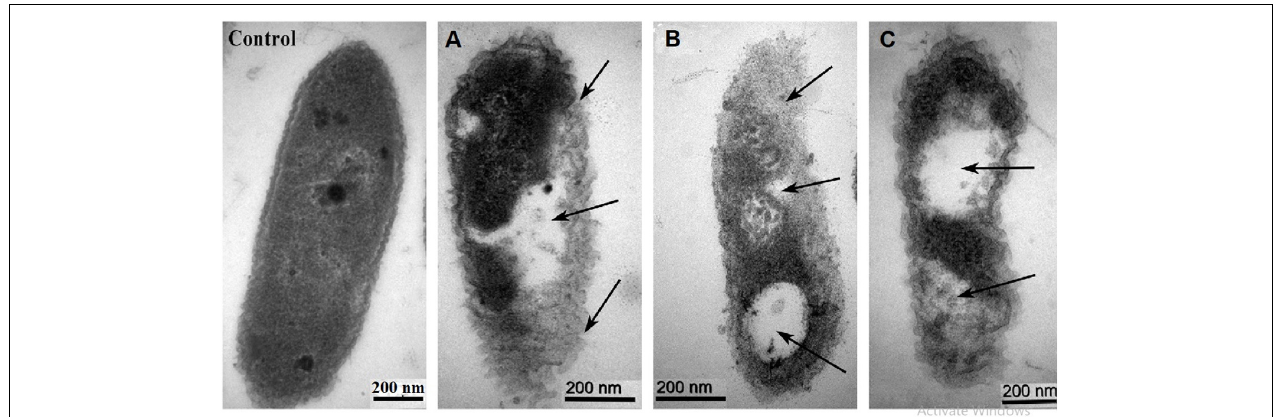
FIGURE 6 | TEM images of Xoo strain GZ 0006 cells treated with (Control) double distilled water (A) ZnO nanoparticles (B) MgO nanoparticles (C) MnO 2 nanoparticles. Magnification 100,000X for Control; 120,000X for (A,B) ; 150,000X for (C) . The arrows indicate the morphological damages of the cell and empty cell content.